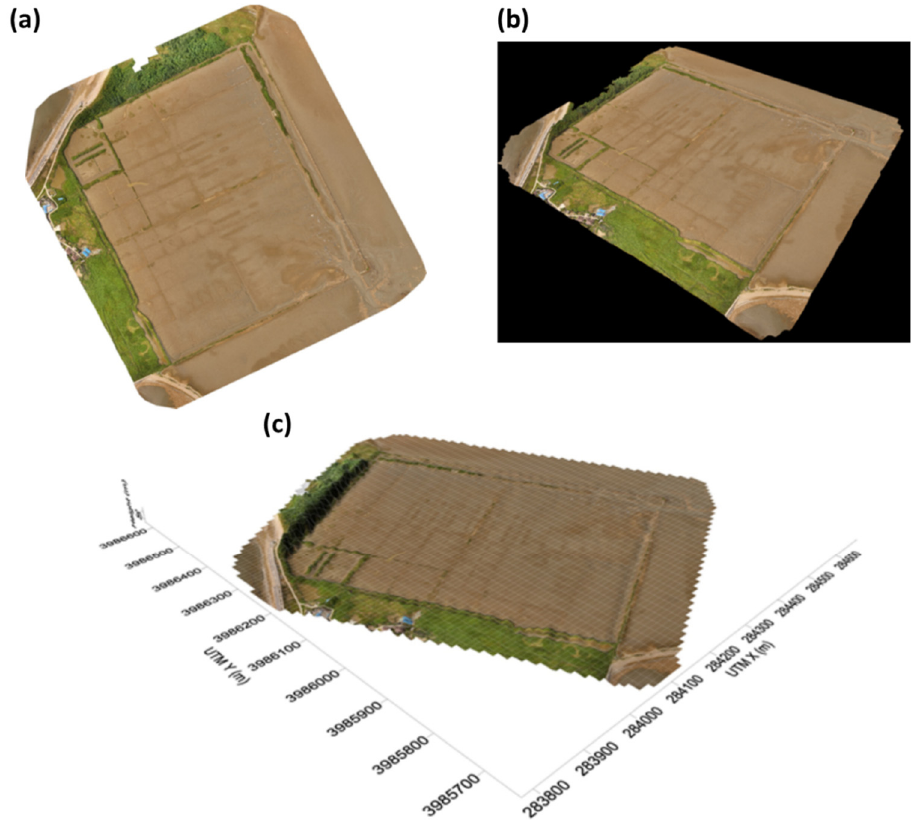
Figure 4. The drone photos: ( a ) the 3D image; ( b ) topographic map; and ( c ) the unused saltern area of the tidal flat in Yubu Island using a DEM (Digital elevation model).